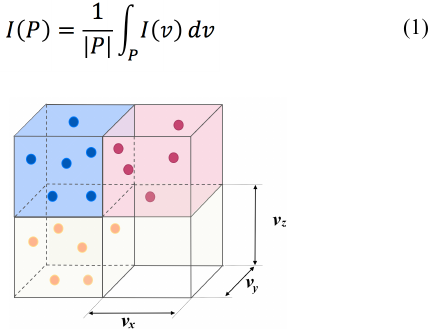
Figure 5. Voxel image of non vertical